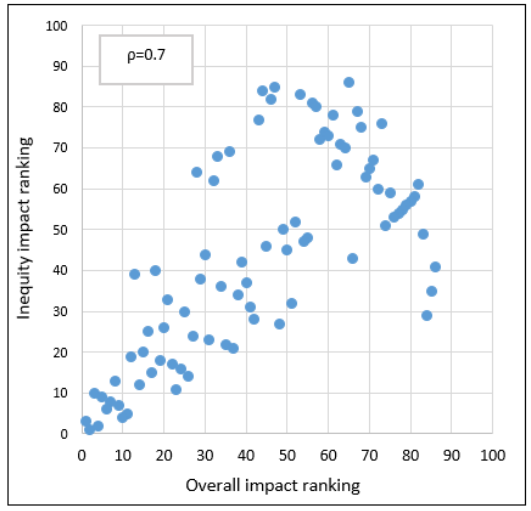
Figure 6. Correlation between overall and inequity impact